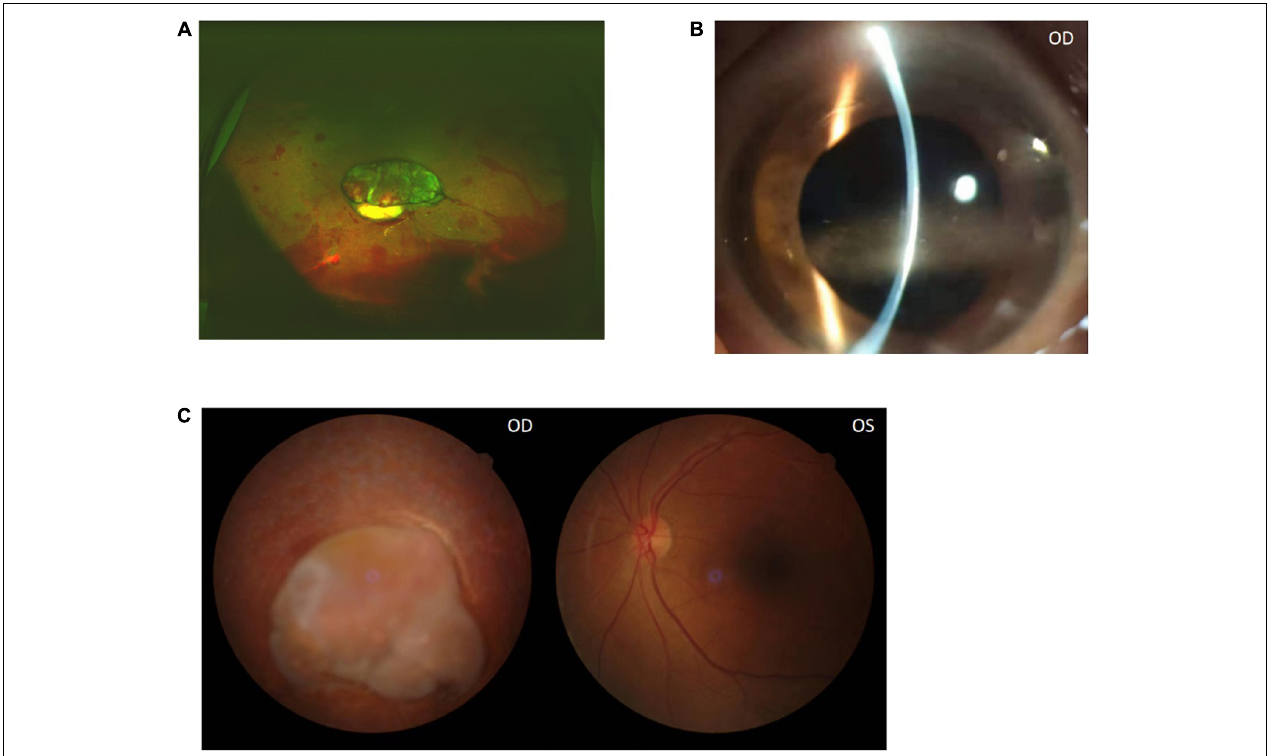
FIGURE 4 | Color funds photograph after the right eye PPV surgery shows the retina contraction (A) . The anterior segment photograph shows cornea band-shaped degeneration 3 months later (B) . Color funds photograph shows there are no significant changes of the ocular fundus after 3 months (C)